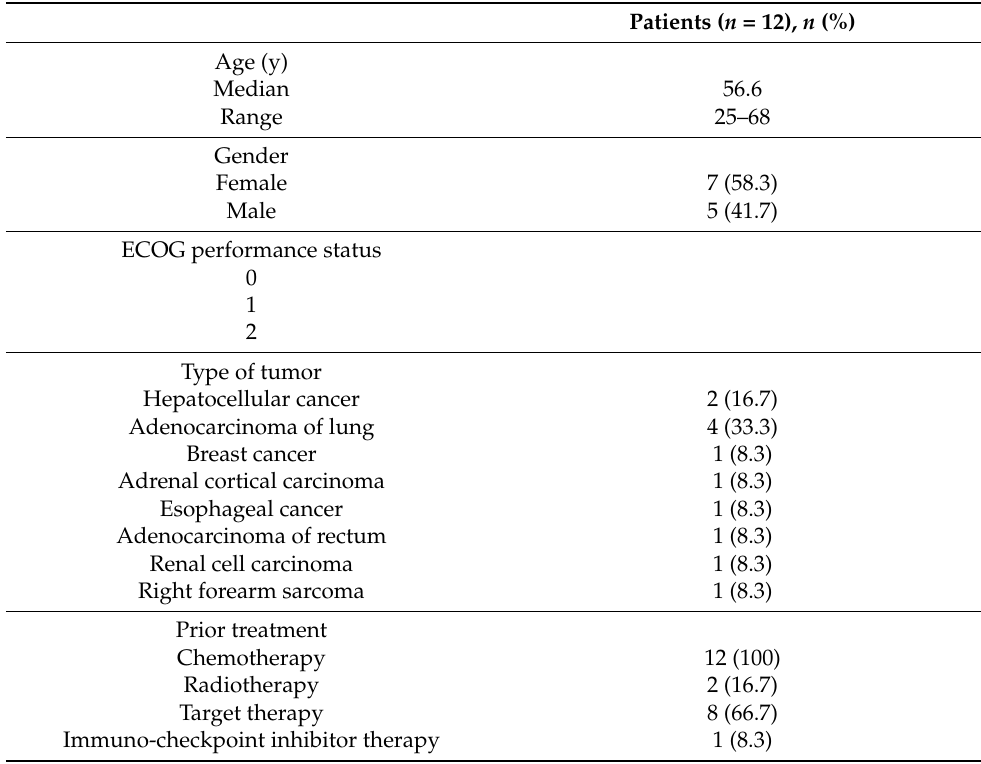
Table 1. Patient